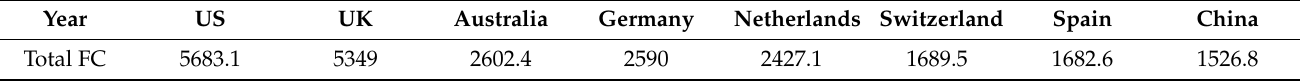
Table 3. The top eight countries with the most FCs of citations from 2013 to 2022.